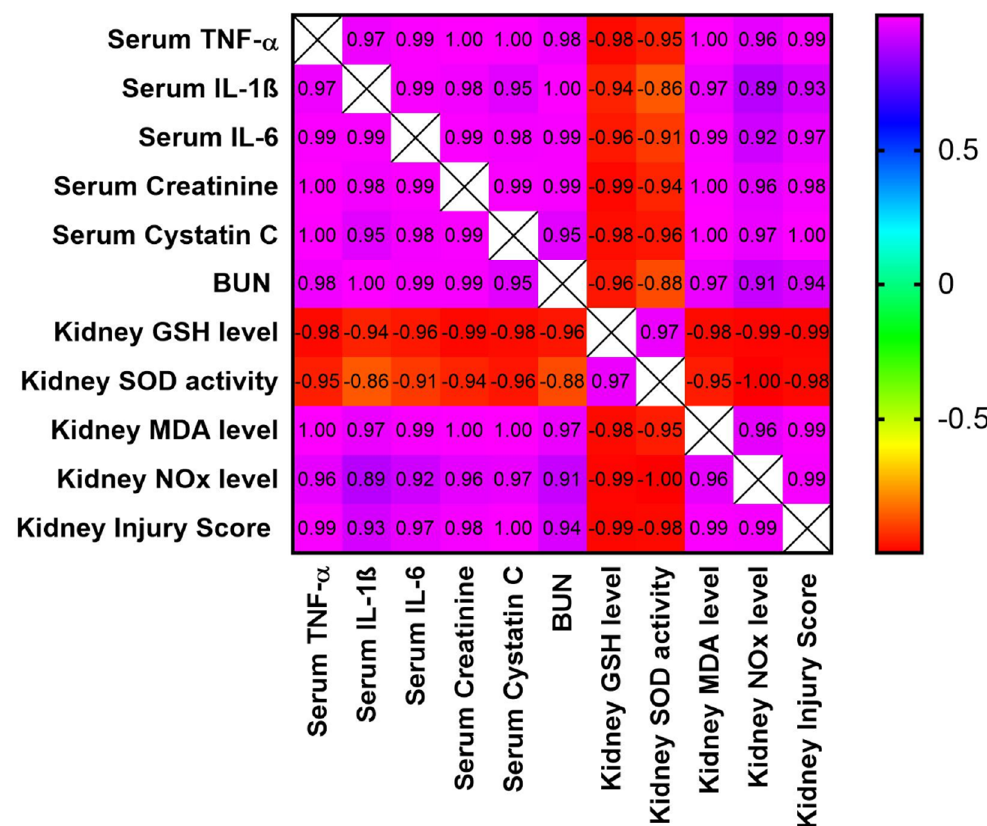
Figure 8. Correlation matrix for different parameters included in the study and kidney injury scores. The correlation coefficient used for analysis is the Pearson correlation coefficient (r). Positive values of r indicate positive correlation, while negative values indicate negative correlation. The correlation was considered strong if the value of r was between |0.6| to |0.79|, while the correlation was considered very strong if r > |0.79|. The range of the colors of the scale on the right, from violet to red, refers to r values from +1 to − 1. IL-1 β : interleukin-1b; IL-6: interleukin-6; TNF- α : tumor necrosis factor- α ; BUN: blood urea nitrogen.